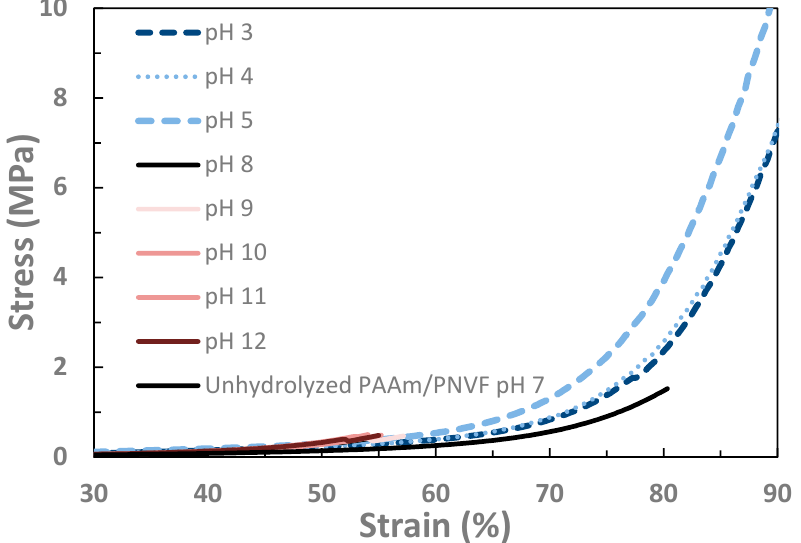
Figure 2. Representative stress–strain curves for partially hydrolyzed PAAc/PVAm IPNs at various solution pH values. At pH values between 3 and 6 the fracture stress and strain increase substantially with a sharp upturn at high strain values relative to both the unhydrolyzed IPN (solid black line) and the hydrolyzed networks outside this pH range (curves at pH values of 9–12) drawn in shades of red are shown to nearly overlap on this scale prior to fracture around 55%). This is consistent with the hypothesized behavior for an IPN with ion complexation between the component networks. Note that gels at pH 3, 4, and 5 did not fracture until strains over 95%, but the data shown are truncated at 90% due to the limited accuracy of compressive testing at such high strains.